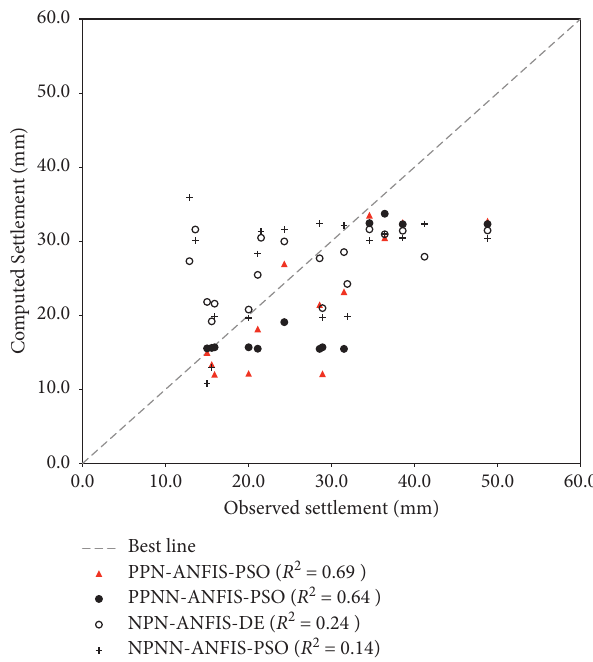
Figure 7: The variation between the observed and predicted set- tlement values over the testing phase and for the best predictive models.